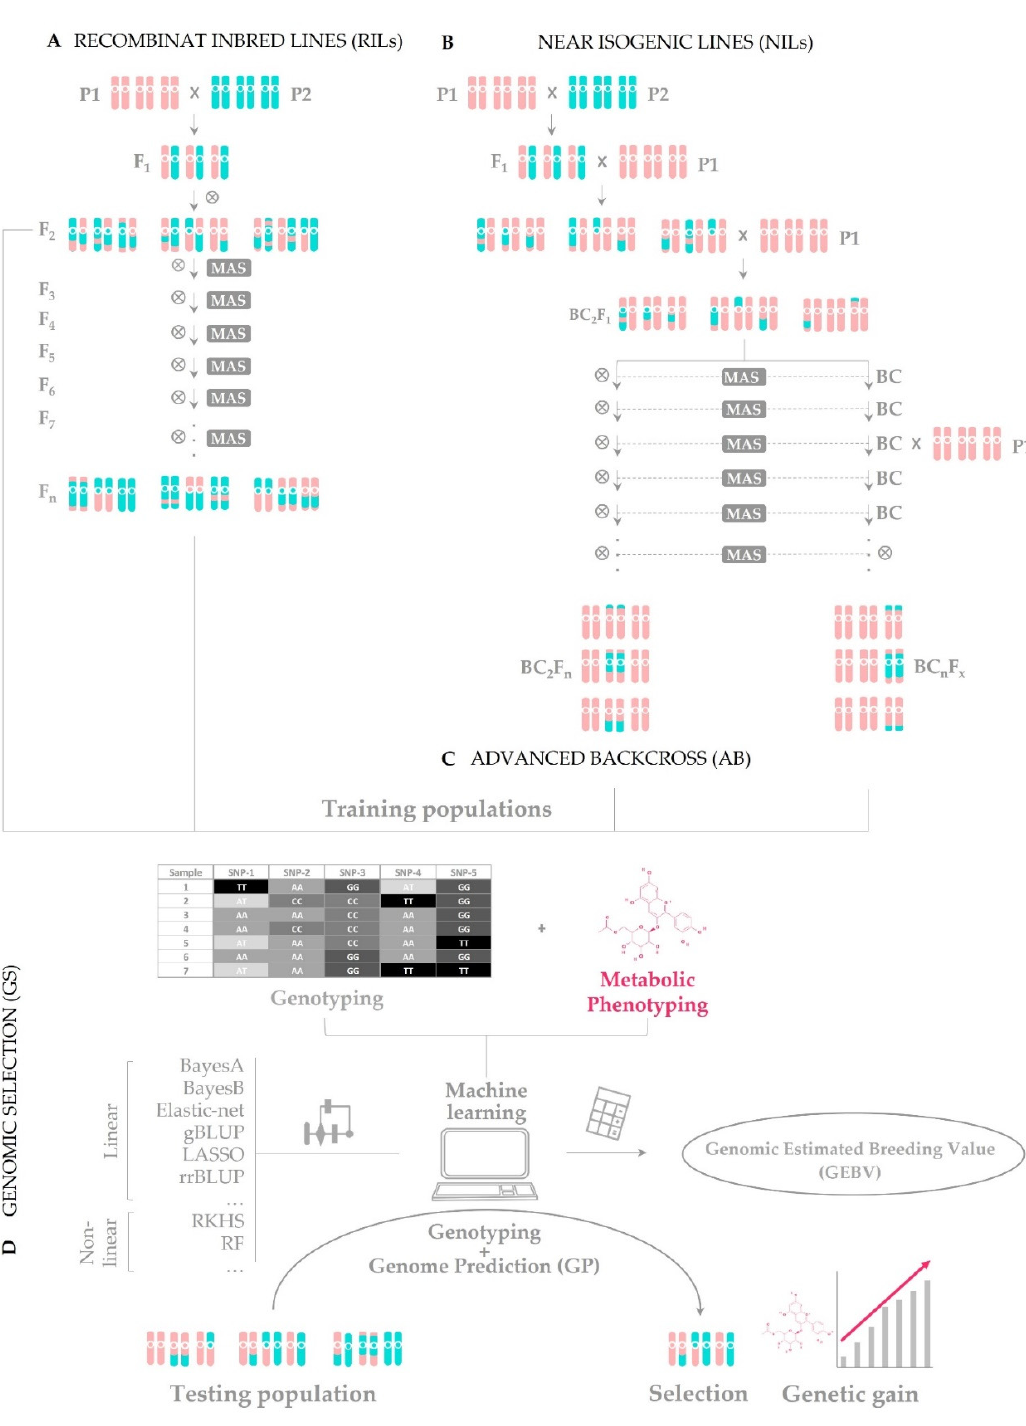
Figure 2. Construction of breeding populations: ( A ) recombinant inbred lines (RILs); ( B ) near isogenic lines (NILs); ( C ) advanced backcross; and ( D ) their use for Genomic Selection (GS). Only some of the possible crossing designs are shown.